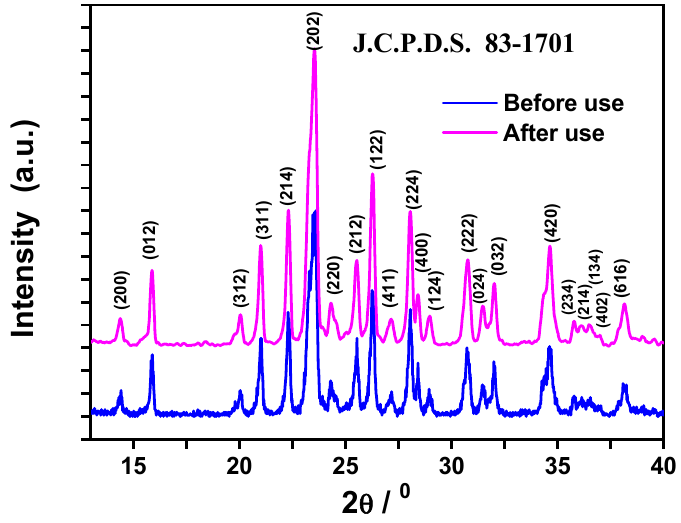
Figure 14. X-ray diffraction pattern of the synthetized Fe 2 (MoO 4 ) 3 nanoparticle powder before and after its use for the removal of MB dye. The Joint Committee on Powder Diffraction Standards (J.C.P.D.S) index file is 83-1701.